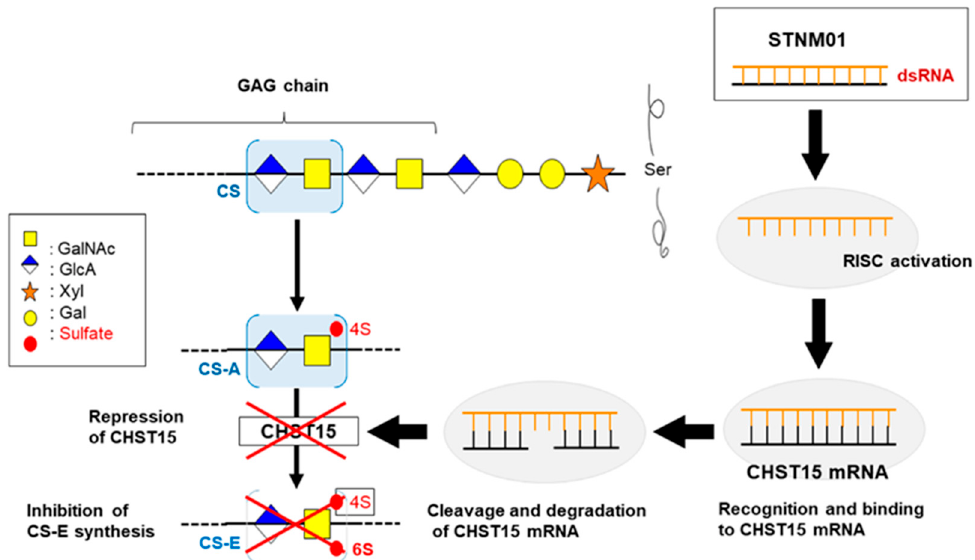
Figure 2. STNM01 blocks the glycosaminoglycan synthesis pathway through RNA-induced silencing complex (RISC) activation. Chondroitin sulfate (CS)-E is a matrix glycosaminoglycan (GAG), a linear polysaccharide composed of a repeating disaccharide unit containing D-glucuronic acid (GlcA) and N-acetyl-D-galactosamine (GalNAc), whose 4- and 6-positions are sulfated. Carbohydrate sulfotransferase 15 (CHST15) is a type-2 transmembrane Golgi protein that transfers sulfate to position 6 of GalNAc (4SO4) residues of CS-A to yield CS-E.